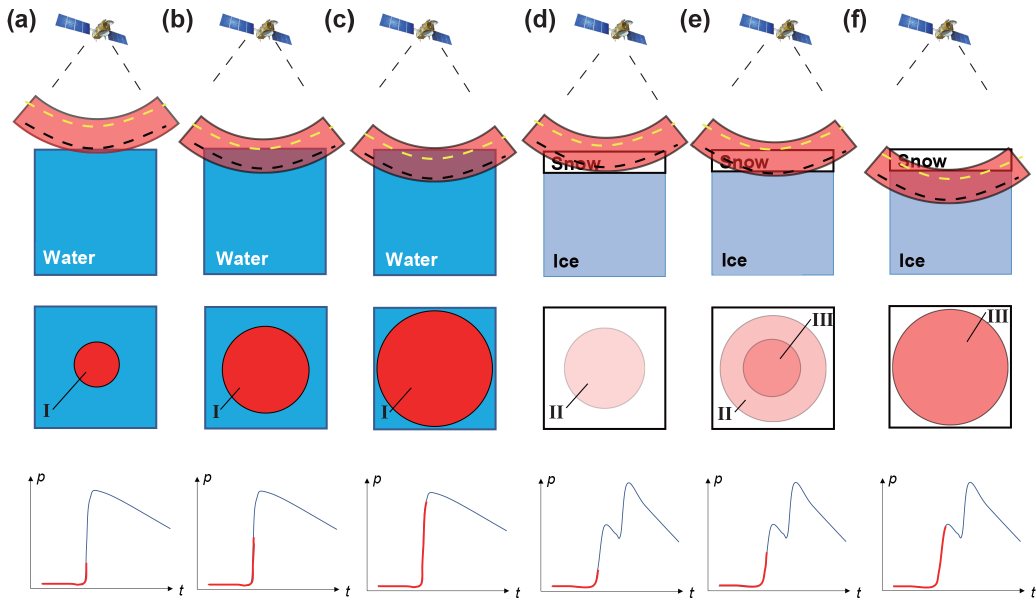
Figure 11. A schematic diagram of pulse-limited radar footprints/illuminated areas and associated waveforms on open-water (a–c) and ice- covered (d–f) lakes. The first horizontal panel shows the side view of the radar pulse and backscattering interfaces. Black and yellow dashed curves denote hypothetical spheres within the radar pulse associated with the 0.1 and 0.5 thresholds, respectively. The second horizontal panel represents the illuminated areas in a vertical view, where circular area I denotes backscattering from the water surface (a–c) , circular area II denotes backscattering from snow layers (d, e) , and circular area III denotes surface backscattering from the snow–ice interface (e, f) . The third horizontal panel shows the waveforms associated with illuminated areas in the second panel. P represents the returned power and t represents the time/gate. The red curve indicates the part of the waveform that has emerged, whereas the blue curve indicates the rest part. Waveforms in panels (a) – (c) indicate moments when a 10%, 50%, and 100% of the waveform peak is met, respectively. Waveforms in panels (d) – (f) indicate moments when a 10%, 50%, and 100% of the peak in the first subwaveform is met, respectively.